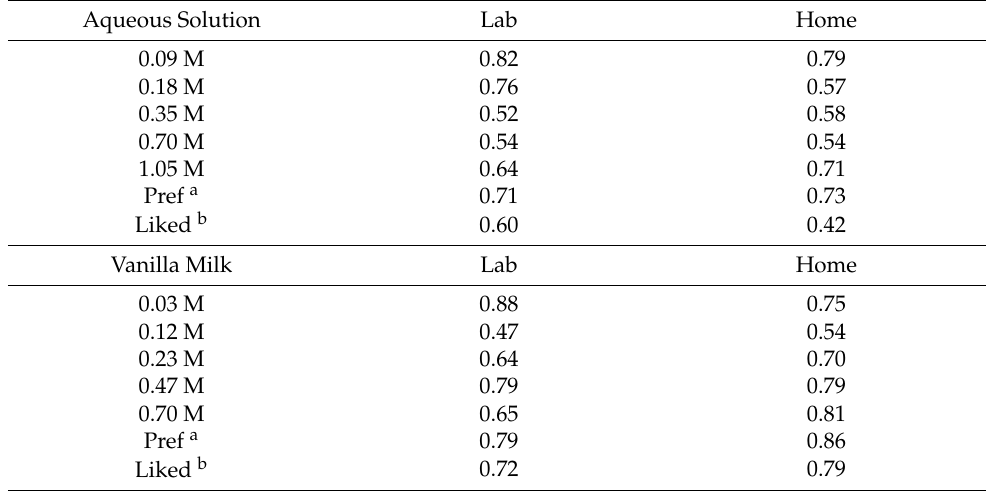
Table 1. Test-retest reliabilities over two sessions (Pearson’s r) for ratings of liking and hedonically optimal sucrose